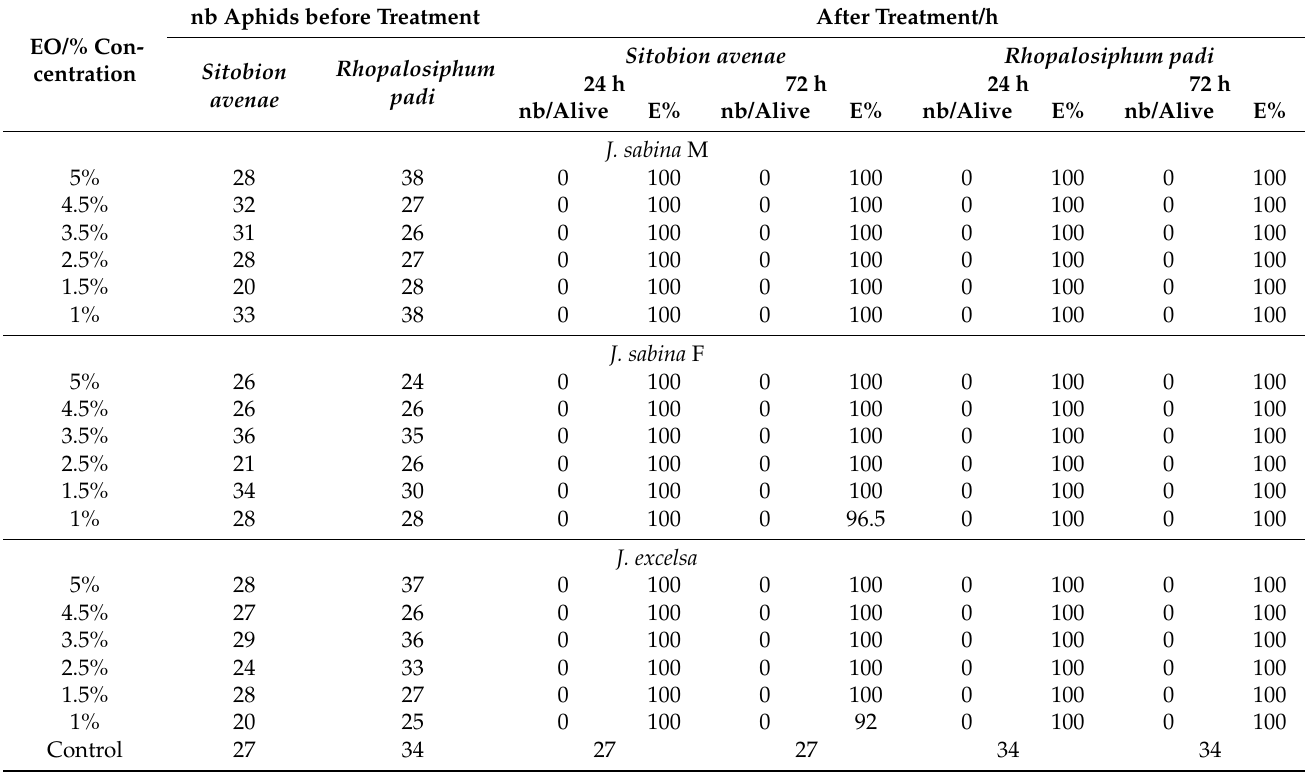
Table 10. Insecticidal action of the semi-commercial extraction of the essential oils (EOs) of J. sabina and J. excelsa on two aphid species. nb Aphids before Treatment After Treatment/h EO/% Con- centration